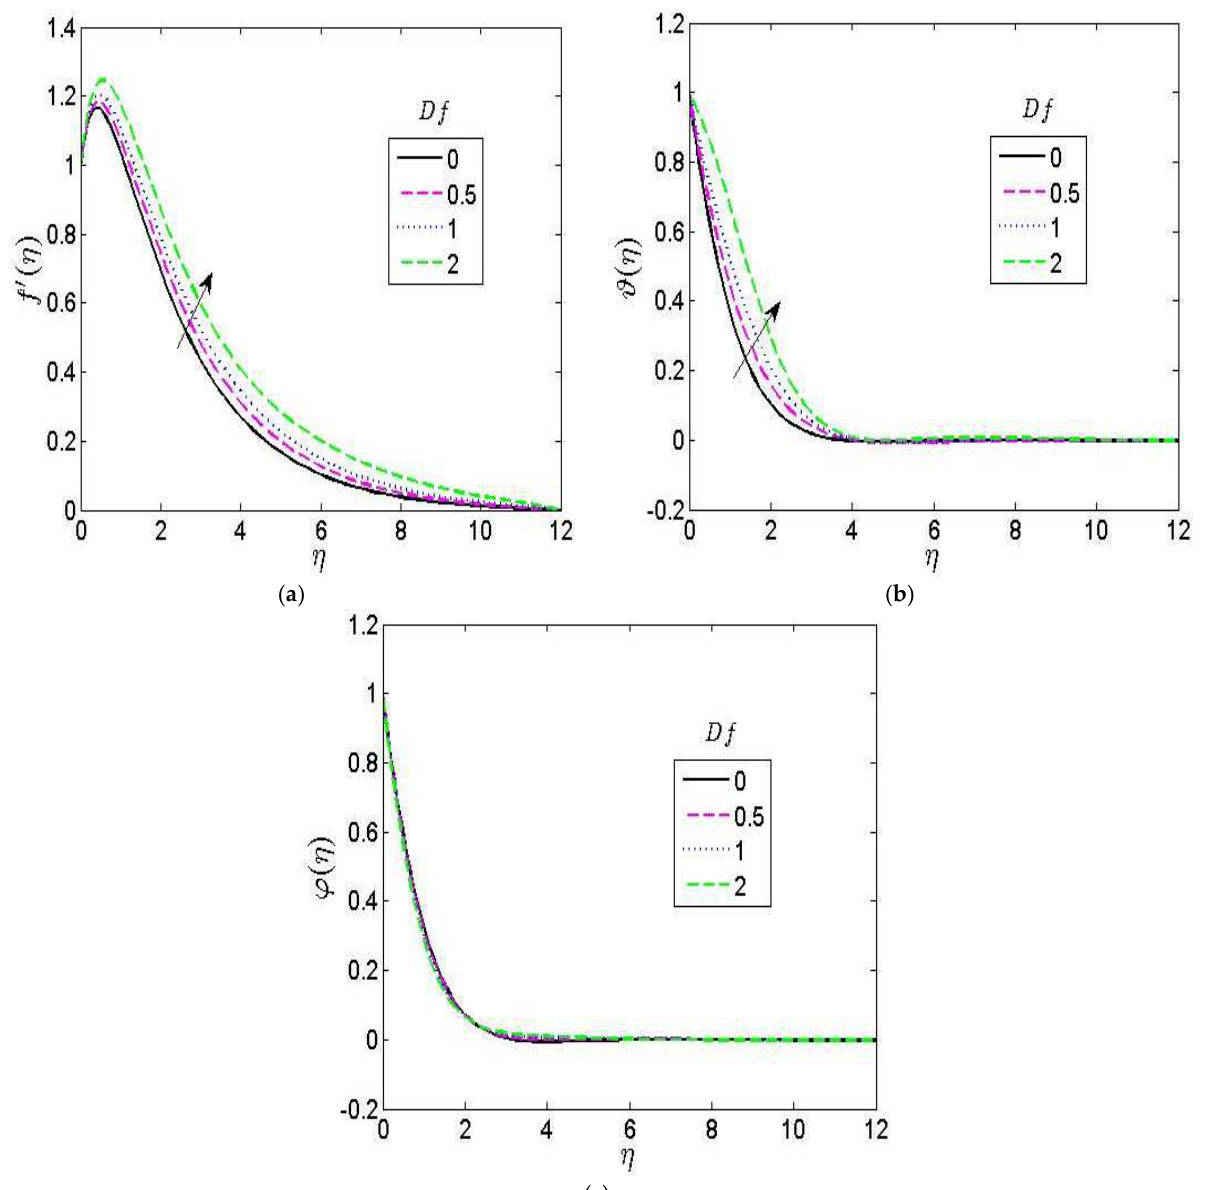
Figure 8. Effect of Dufour parameter Df on ( a ) velocity, ( b ) temperature, and ( c ) concentration pro- files.